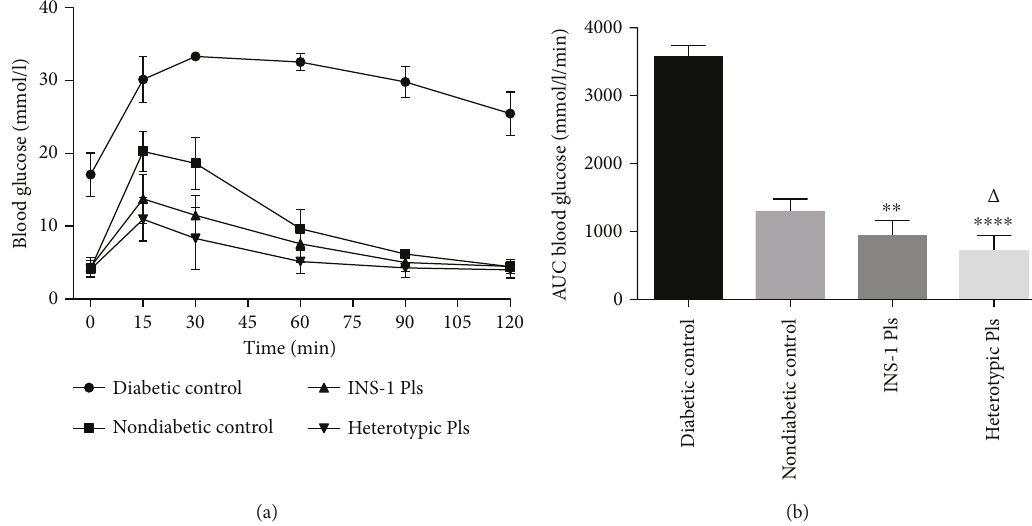
Figure 8: Subcutaneous pseudoislet transplantation on glucose tolerance in STZ diabetic BALB/c nu/nu mice. (a) Two days after diabetes reversal, intraperitoneal glucose tolerance was measured. Values are mean ± SD, n = 10 . (b) Areas under the blood glucose curve expressed as mmol/l/min. ∗∗ p < 0 01 and ∗∗∗∗ p < 0 0001 compared to nondiabetic control group. Δ p < 0 05 compared to INS-1 PI transplantation